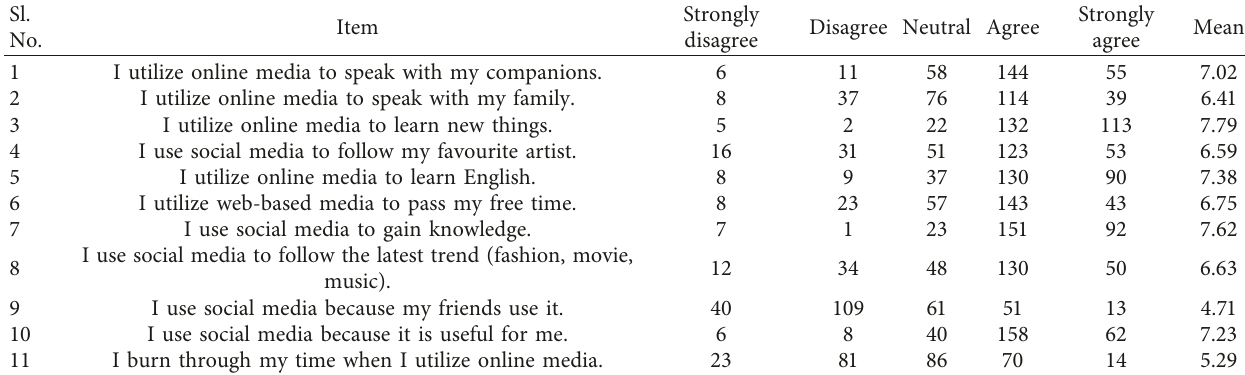
Table 6: Allocation, frequency, and mean on the elements influencing the usage of social media.